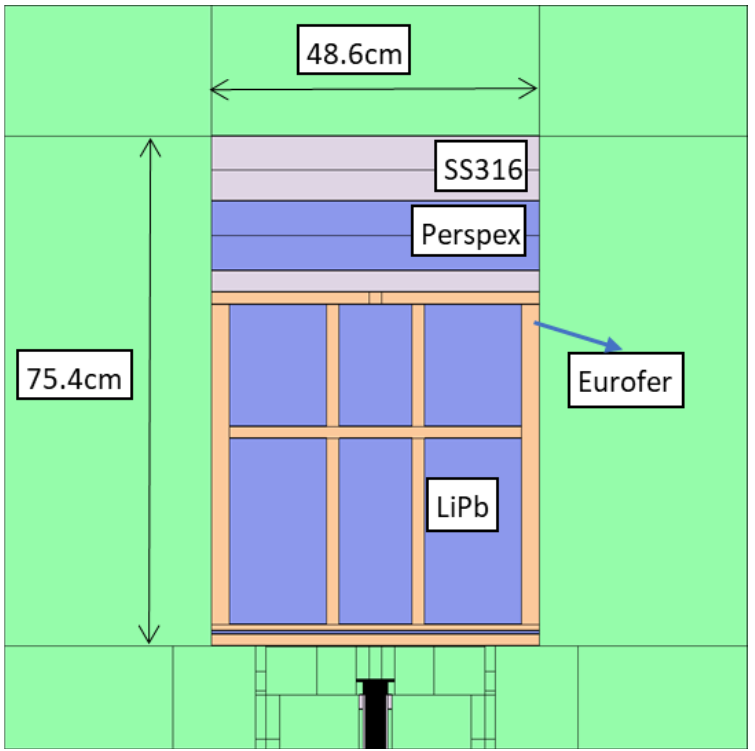
Figure 1: View of the FNG WCLL geometrical